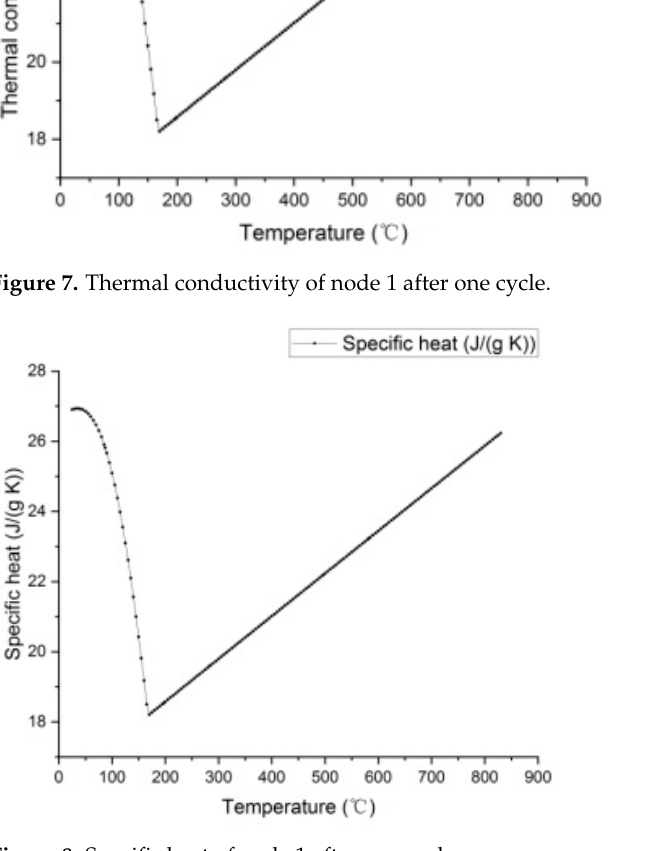
Figure 8. Specific heat of node 1 after one cycle.